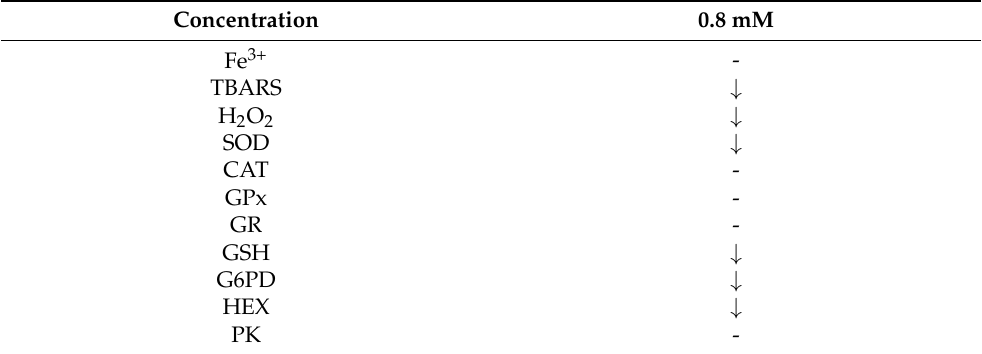
Table 2. Comparison of the data for the different markers when treating the erythrocytes with 0.8 mM versus 0.6 mM HU for 1